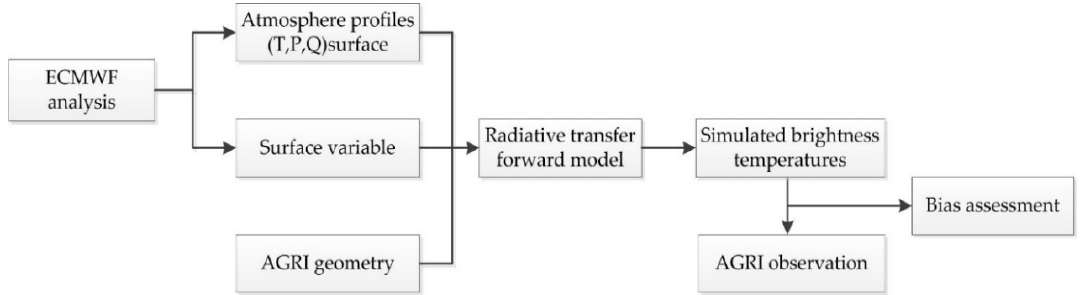
Figure4. Flowchartforthecouplingofthenumericalweatherprediction(NWP)outputandtheradiative transfer models used to simulate the Chinese FY–4A / AGRI infrared observations for bias